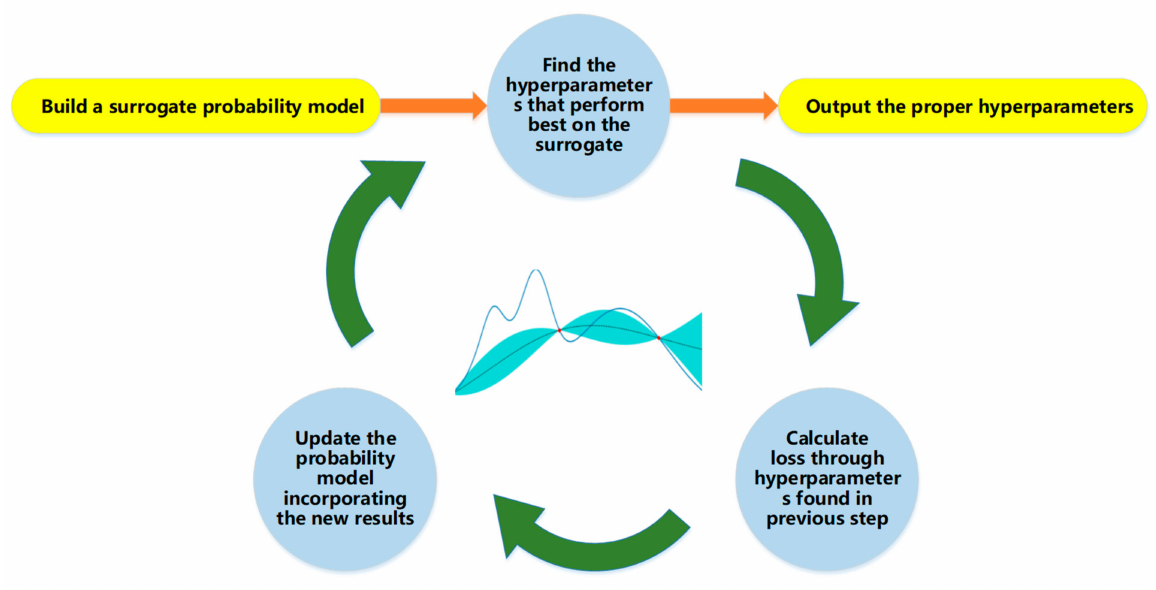
Figure 4. Process of Bayesian